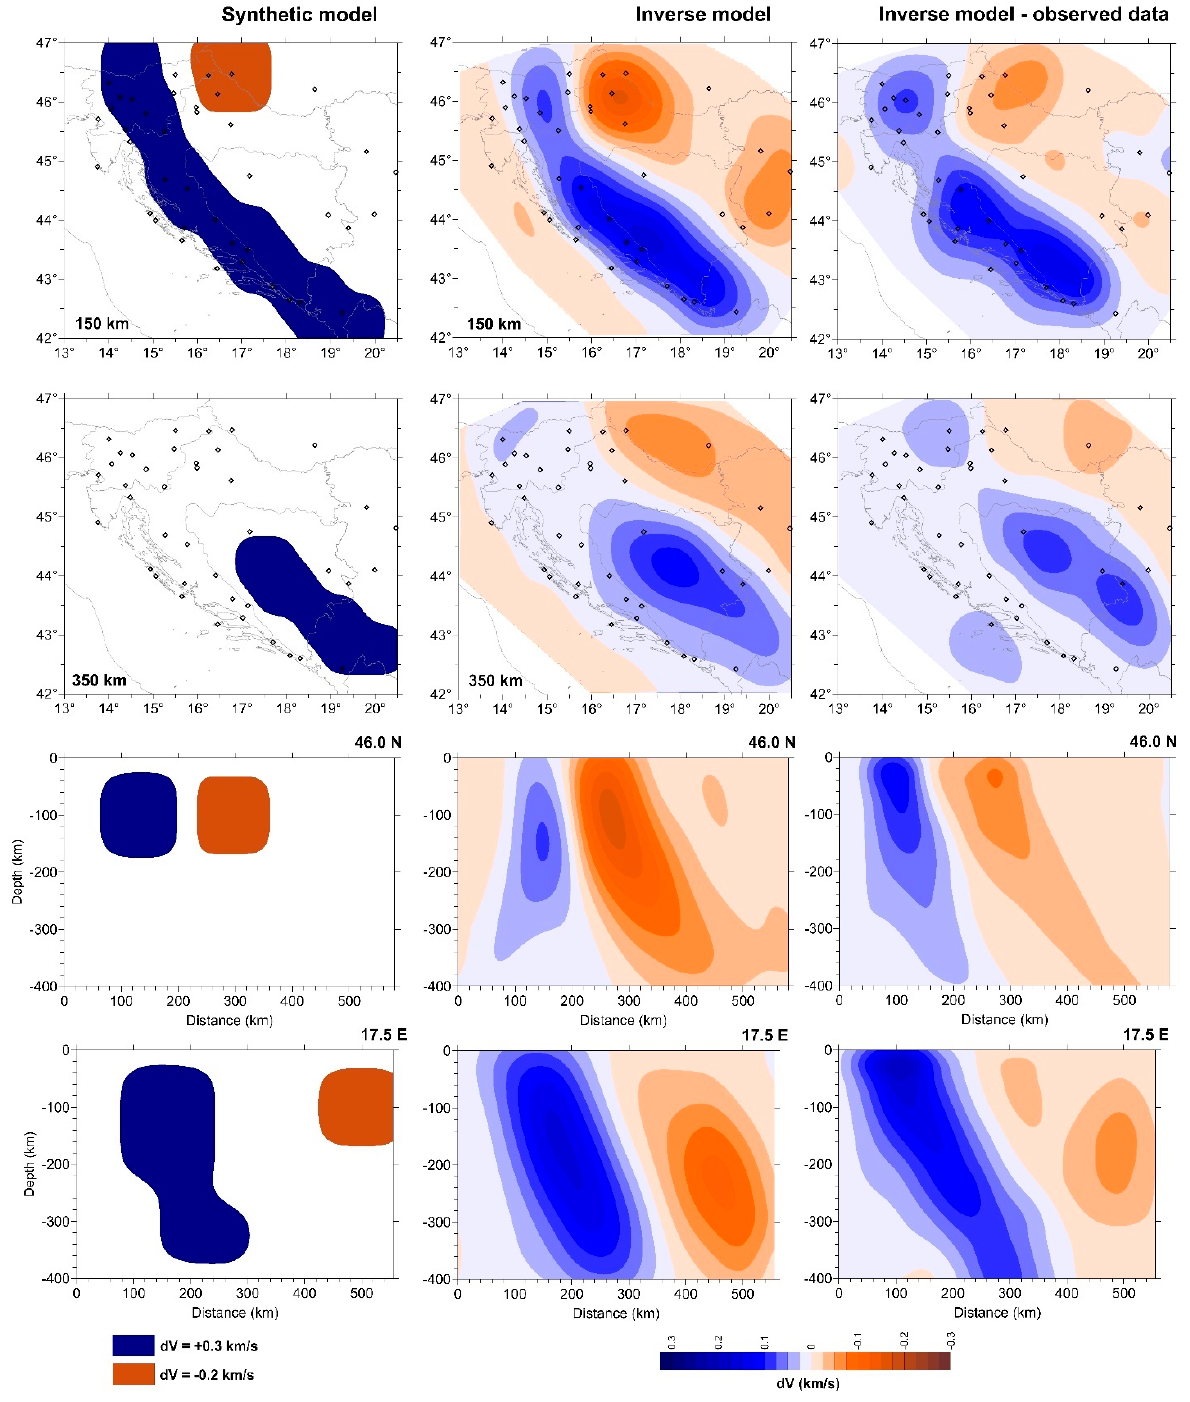
Figure 6. Second model. Three-dimensional velocity models showing two depth slices (150 km and 350 km, upper part) and two cross sections (46 °N and 17.5 °E, lower part). A shallow high-velocity vertical slab in the synthetic model is assumed in the Northern Dinarides, while deep slab in the Southern Dinarides is divided in two parts, and the deeper part of the slab is shifted towards the northeast (left side). The inverse model recovered from synthetic travel-time residuals is shown in the middle part, and the inverse model of observed travel-time residuals in the SU-model [8] is shown in the right side. Better correlation between the shapes of the anomalies of the inverse models for the synthetic and the observed data than for the first model (Figure 5) can be